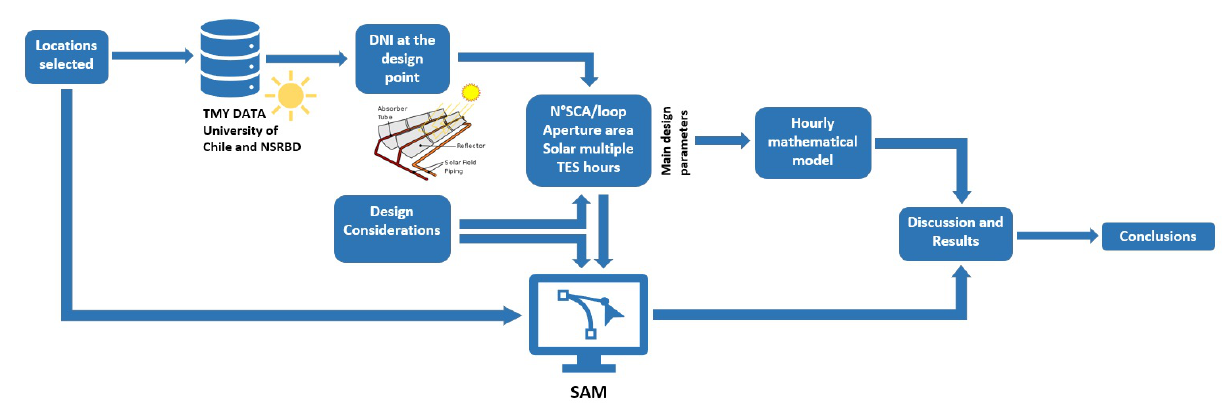
Figure 2. Sketch of the methodology presented.